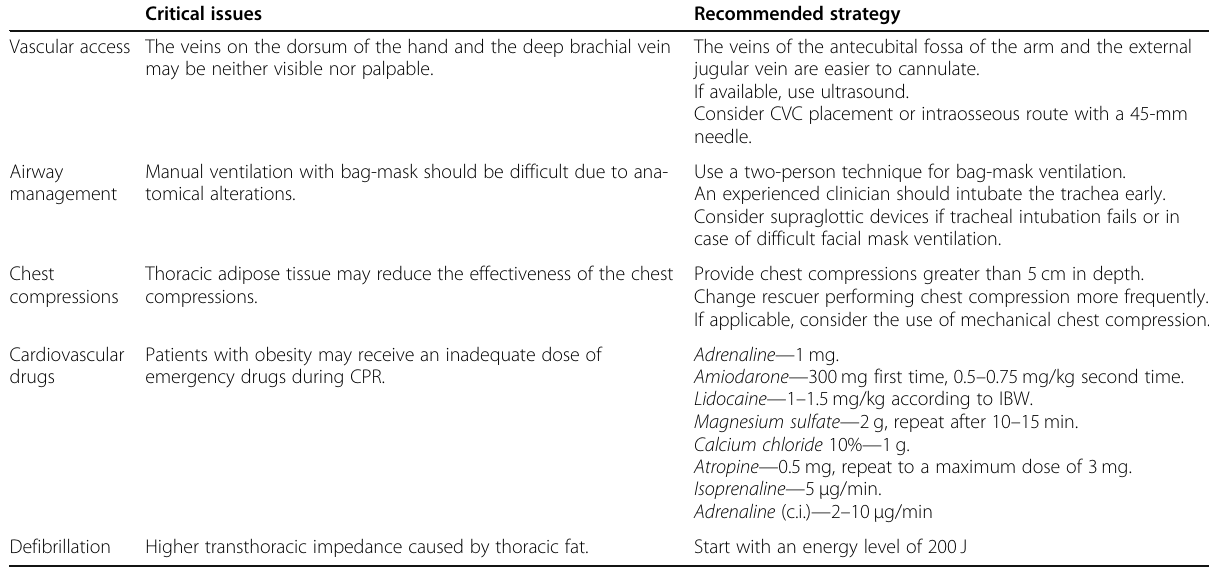
Table 1 Key issues and optimal strategies for CPR in obese patients Critical issues Recommended